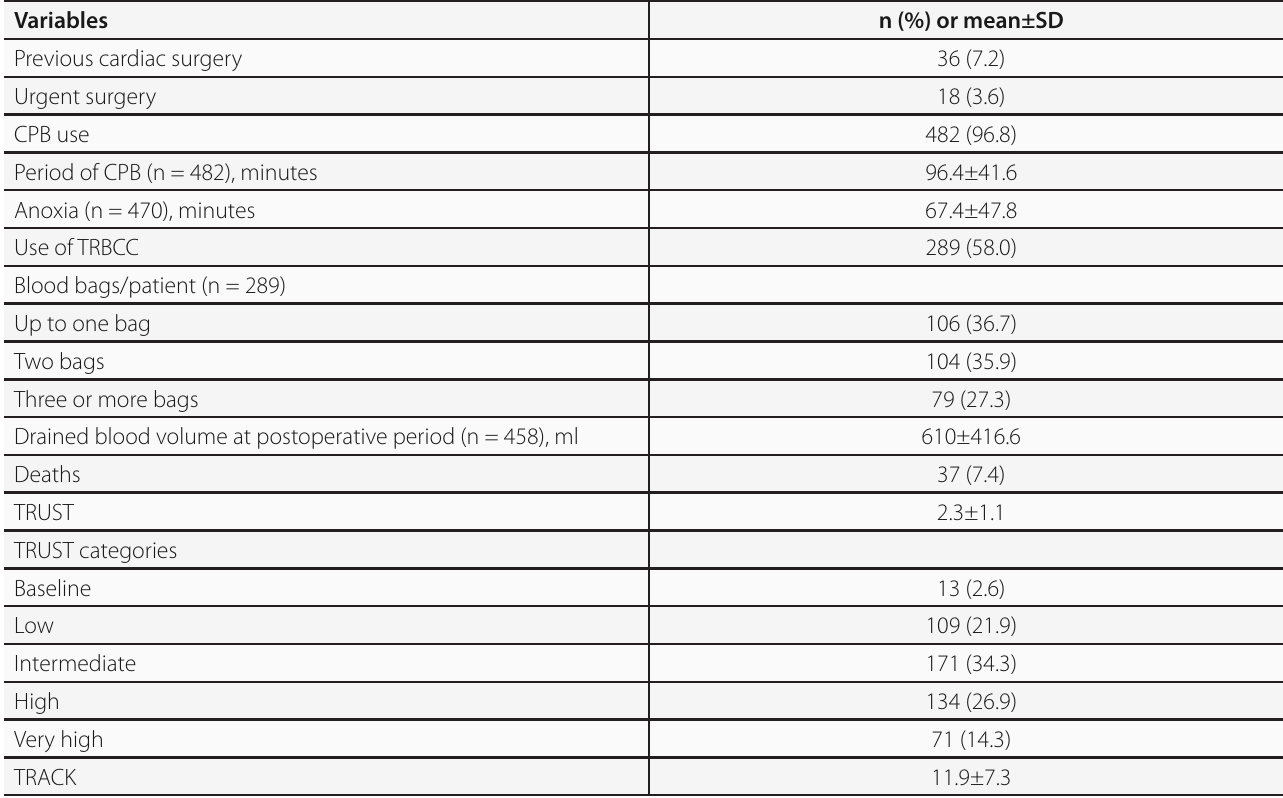
Table 3. Characteristics of surgeries analyzed, mortality rate, and risk scores calculated (TRUST and TRACK) for 498